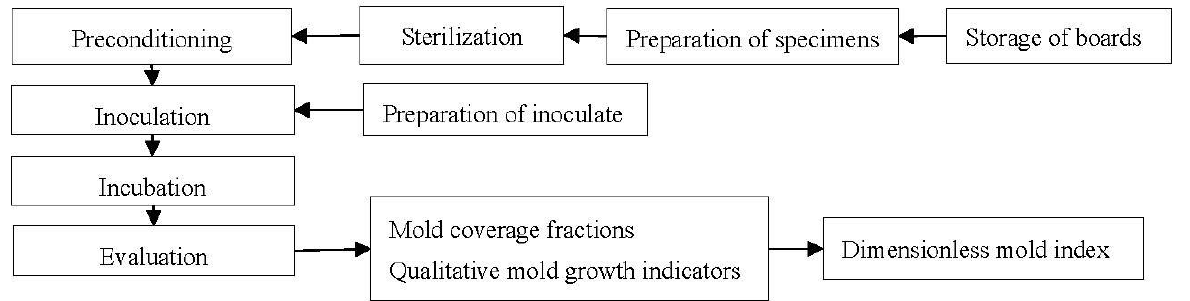
Figure 1. Scheme of the mold growth experiment.